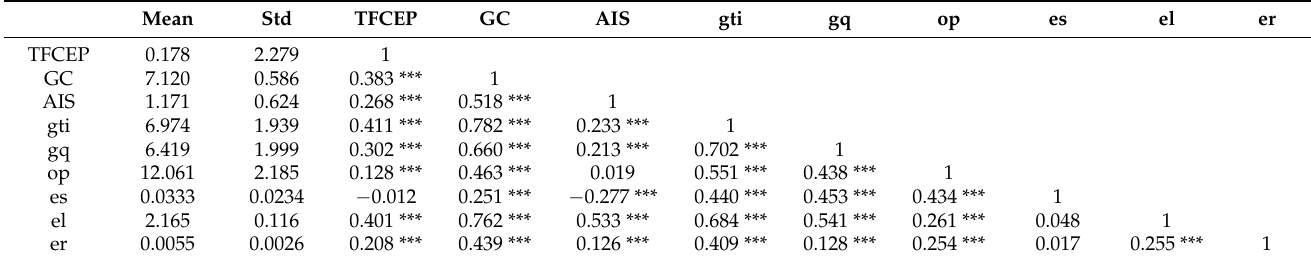
Table 1. Descriptive statistics and correlation analysis of